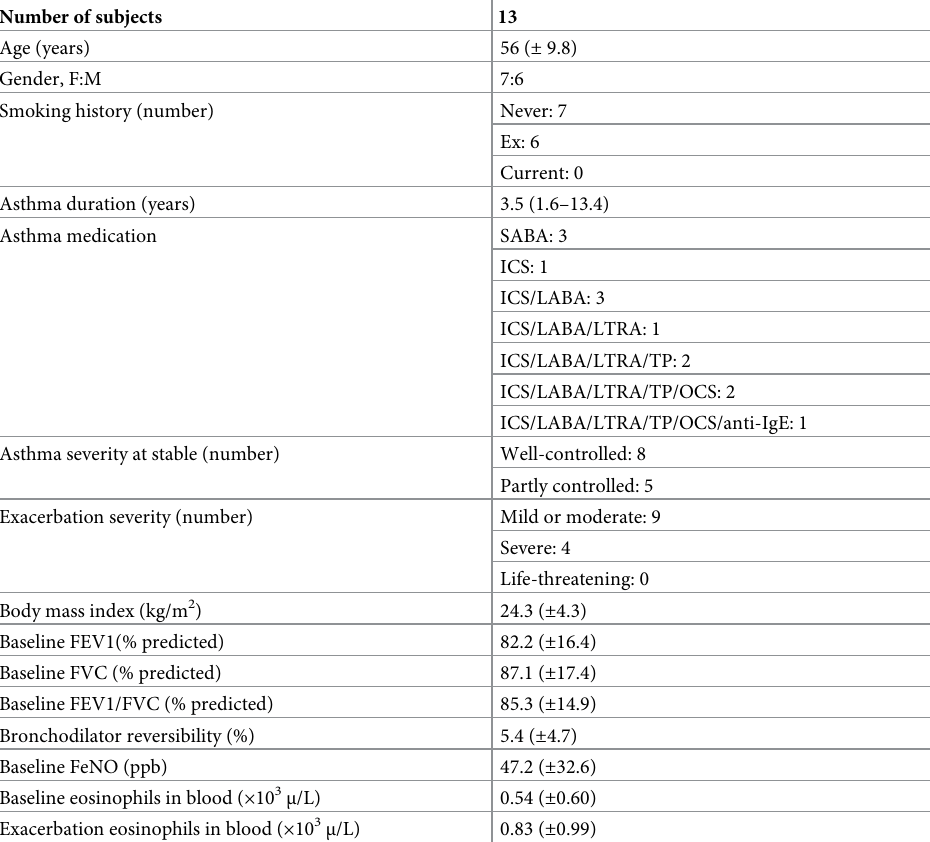
Table 1. Patient